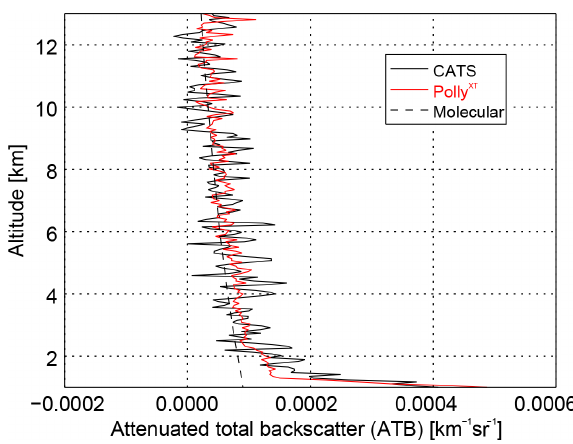
Figure 8. The mean CATS and Polly XT ATB profiles from the CATS overpass of the Leipzig, Germany, EARLINET site at 00:18:19UTC on 30 July 2015. CATS passed within 41km of the EARLINET